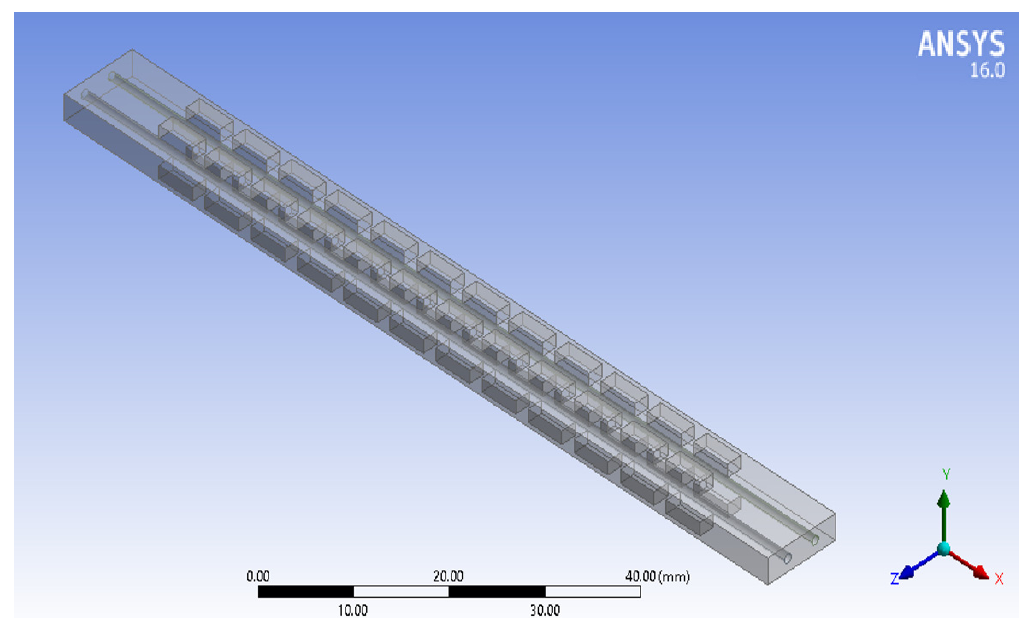
Figure 2. Three-dimensional view of microchannel heat sink model.